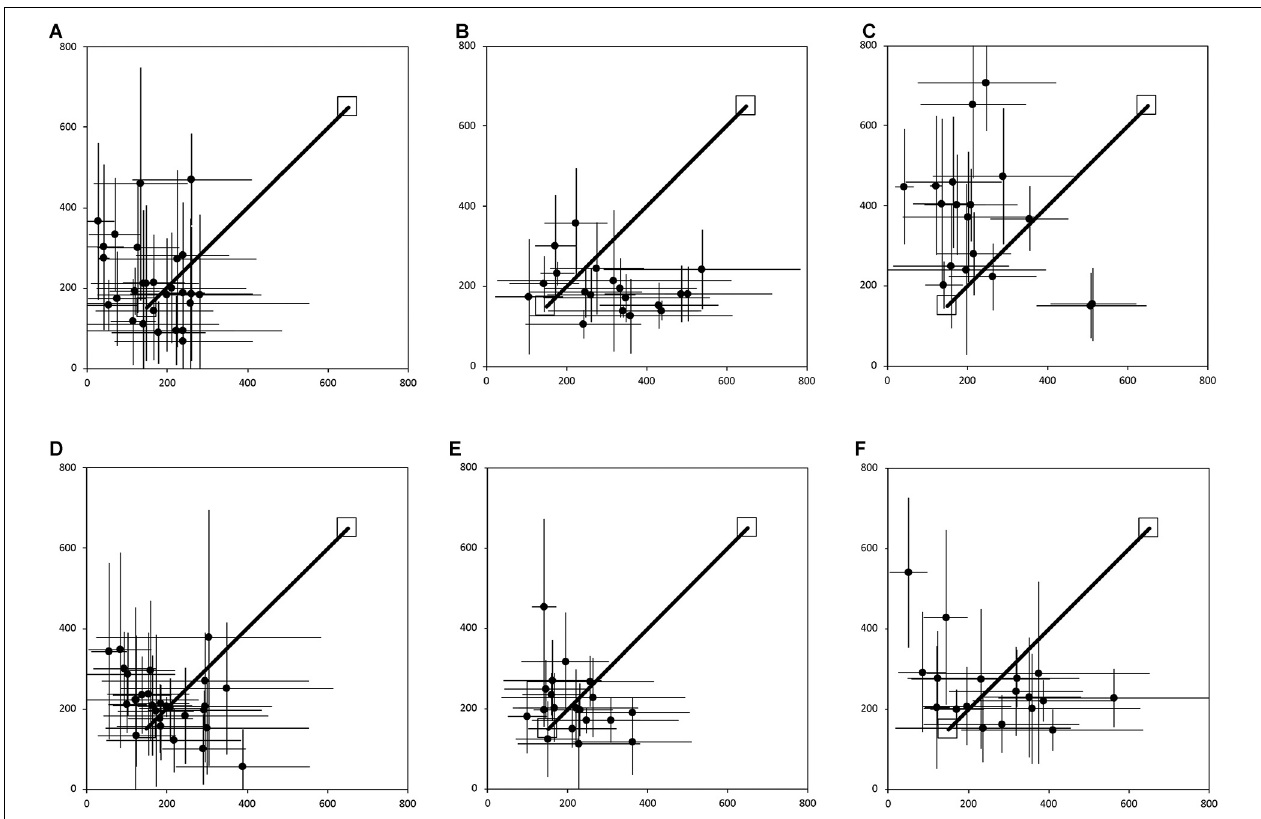
FIGURE 2 | Average end location of individual participants’ return paths, following a straight 7 m outward path in the egocentric homing task. The horizontal and vertical error bars represent the standard deviation for each individual across one session. The solid line indicates the outward straight path. The top right square indicates the starting point of the return path. The bottom left square indicates “home.” In Session 1, participants were guided by the left arm, and in Session 2 they were guided by the right arm. (A) TD, Session 1. (B) DS, Session 1. (C) WS, Session 1. (D) TD, Session 2. (E) DS, Session 2. (F) WS, Session 2. Room size: 800 cm × 800